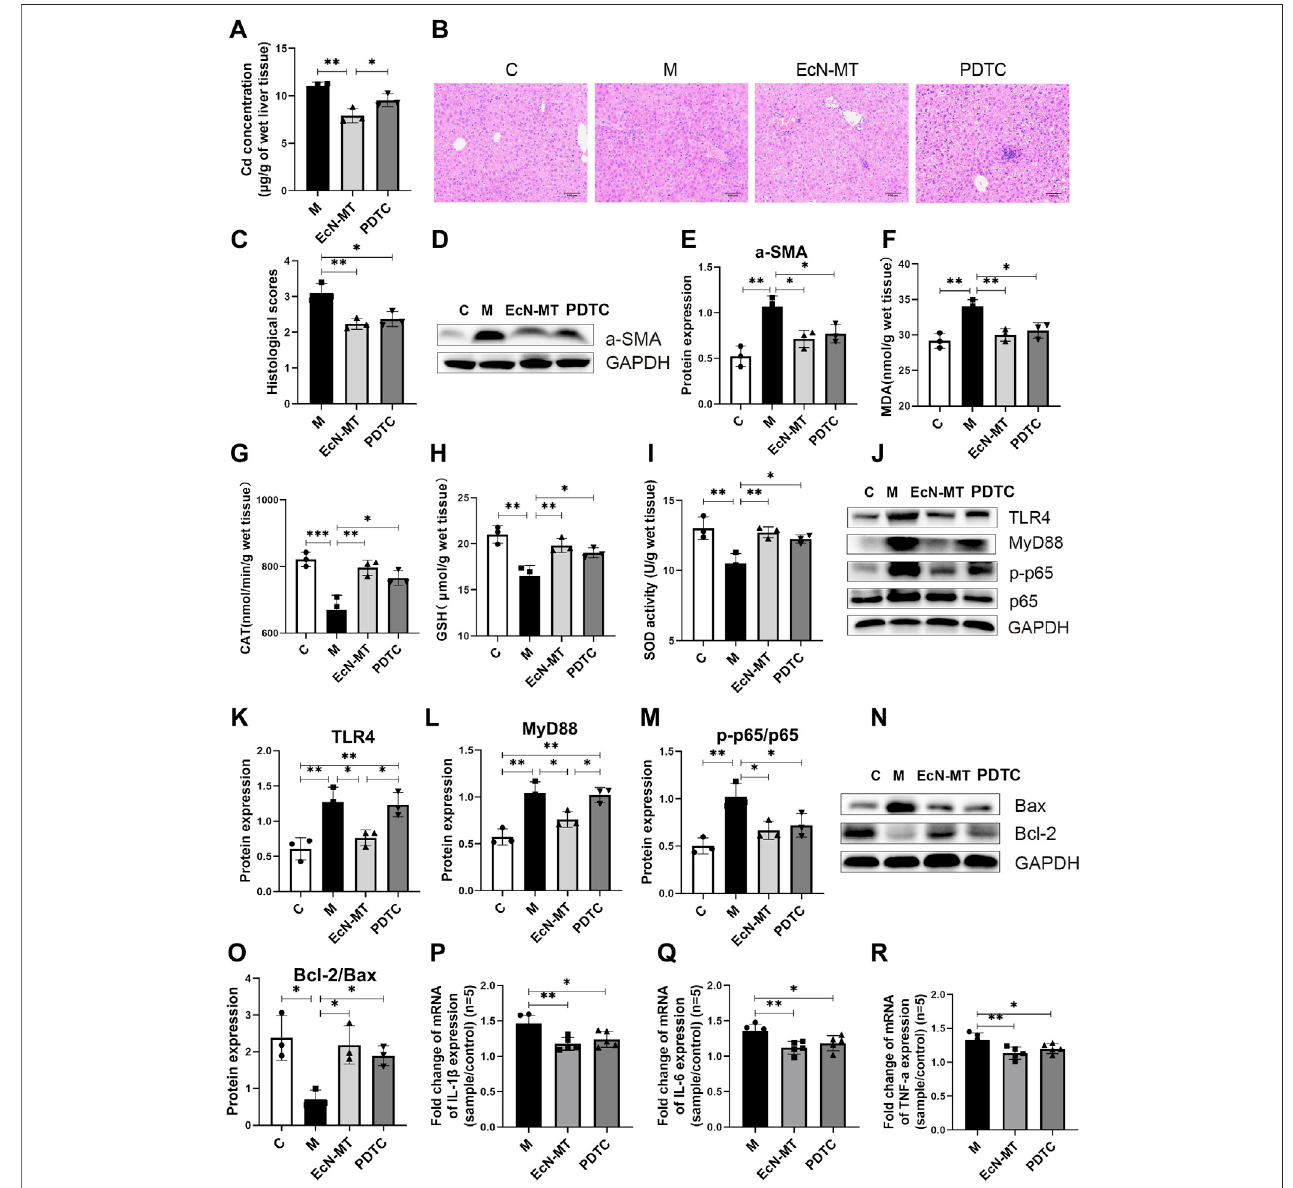
FIGURE5| SuppressionofNF- κ Bactivationreducedhepaticin fl ammationandoxidativestress.Valuesarepresentedasmeans±SD( n =3,exceptq-PCRresults repeated fi vetimes). (A) Cd concentrationsinthe liverassayedbyICP-MS. (B) HE stainingimage ofliver tissue (200×). (C) Histological scoreofliverinjury.After 8 weeks of exposure to drinking water, the pathological changes of liver tissues stimulated by cadmium chloride (0.545 mM) were determined. (D) Western bloting analysis of a-SMAexpressioninlivertissues. (E) Therelativeexpressionsofa-SMAwerequanti fi edbyImageJ,expressionsofa-SMAwerequanti fi edbyImageJ.GAPDHwas used as an internal control. The activity of MDA; CAT; GSH; SOD, activity of (F) MDA; (G) CAT; (H) GSH; (I) SOD. (J) Western bloting analysis of TLR4, MyD88, p-p65, p65 expression inliver tissues.The relative expressions of (K) TLR4, (L) MyD88, (M) p-p65/p65were quanti fi edbyImageJ. GAPDHwas used asaninternal control. (N) Western bloting analysis of Bax, Bcl-2 expression in liver tissues. (O) The relative expressions of Bcl-2/Bax were quanti fi ed by ImageJ. GAPDH was used as an internal control. The relative mRNA expressions of (P) IL-1 β , (Q) IL-6, (R) TNF- α in liver tissues were detected by q-PCR. * p < 0.05, ** p < 0.01, *** p < 0.001.